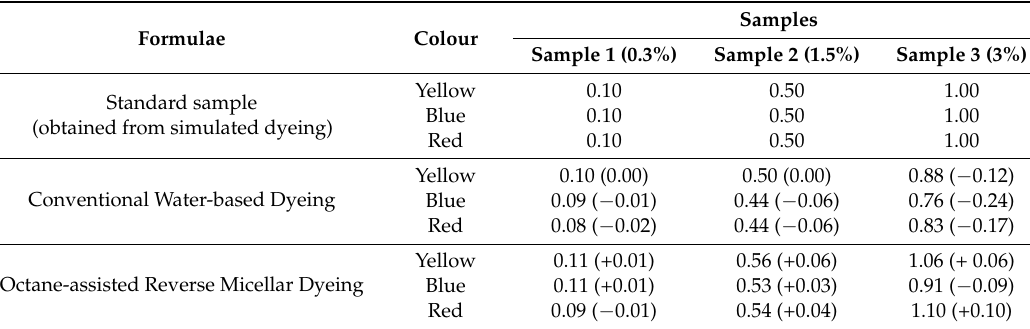
Table 5. Colour matching